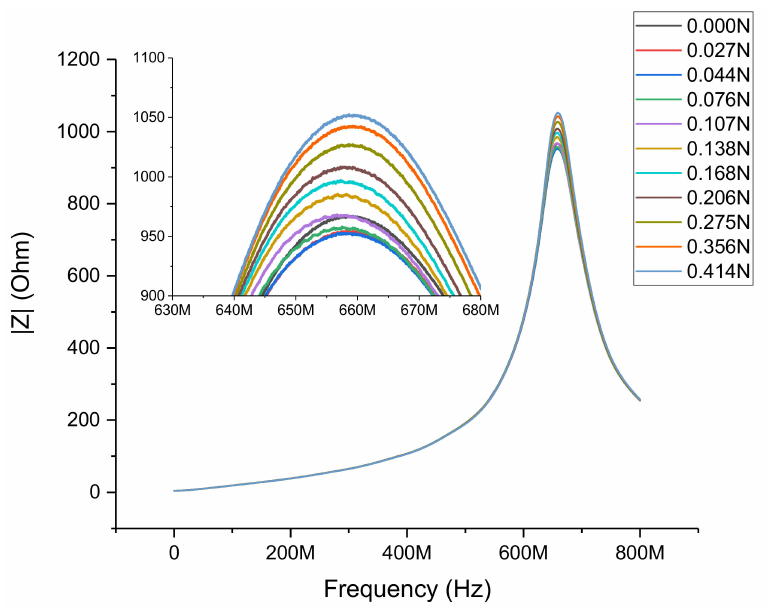
Figure 13. Absolute impedance of the force sensor vs. measurement frequency at some selected force loads. The inset shows a more detailed view of the resonance.